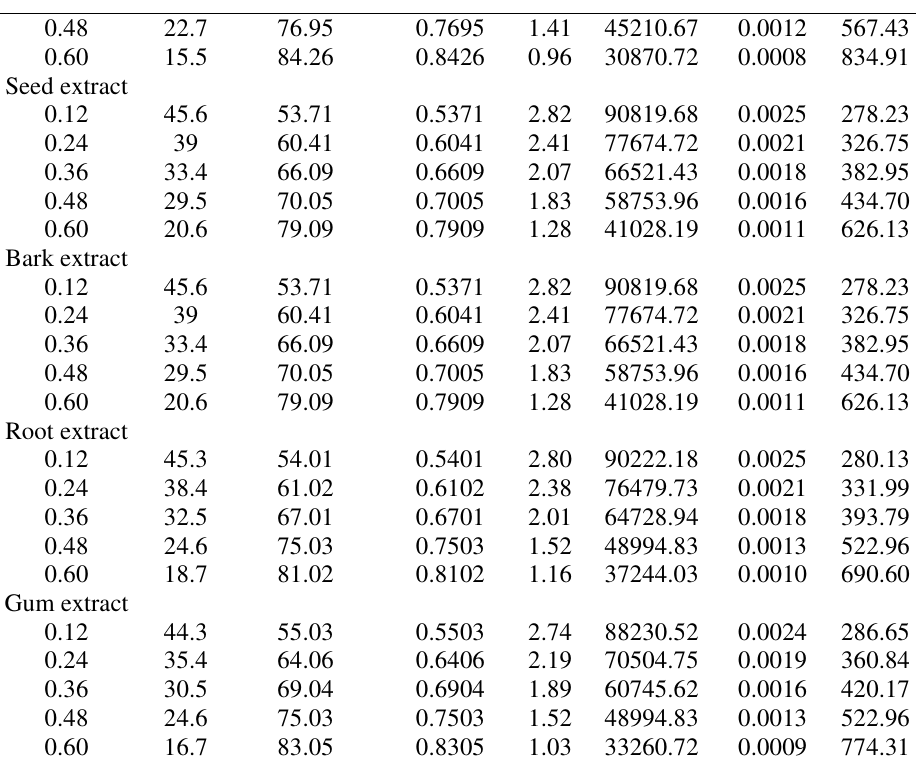
Table 4. Effect of extract of different parts of plants acacia Senegal on mass loss data